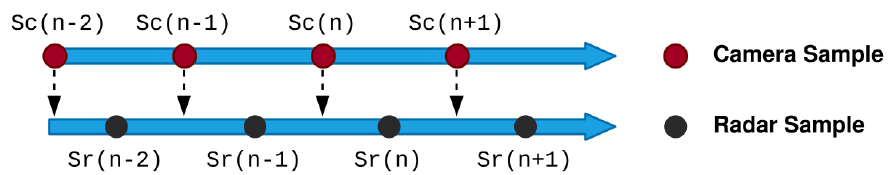
Figure 2. Radar and camera time-alignment